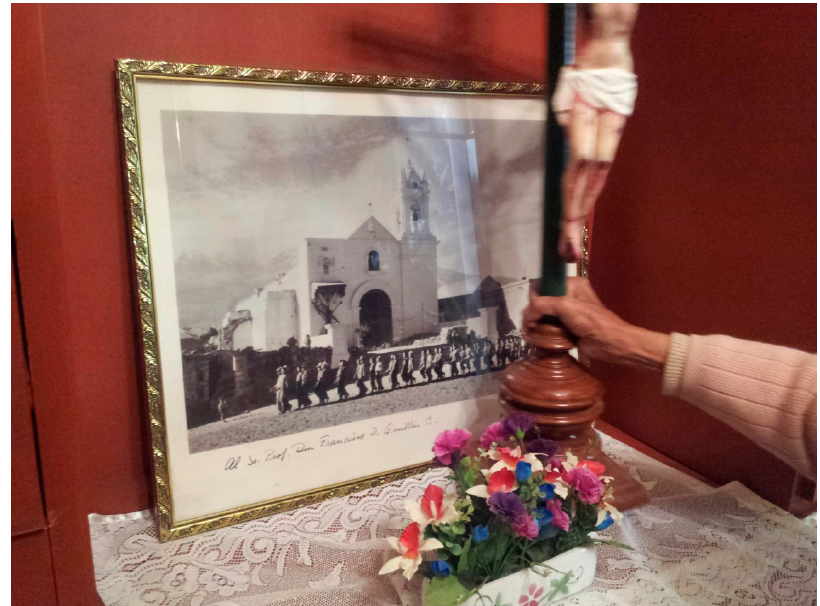
Figure 4. The caretaker of the Catholic church in Carmen Alto shows me a photograph of its original, late colonial church built in 1817. May